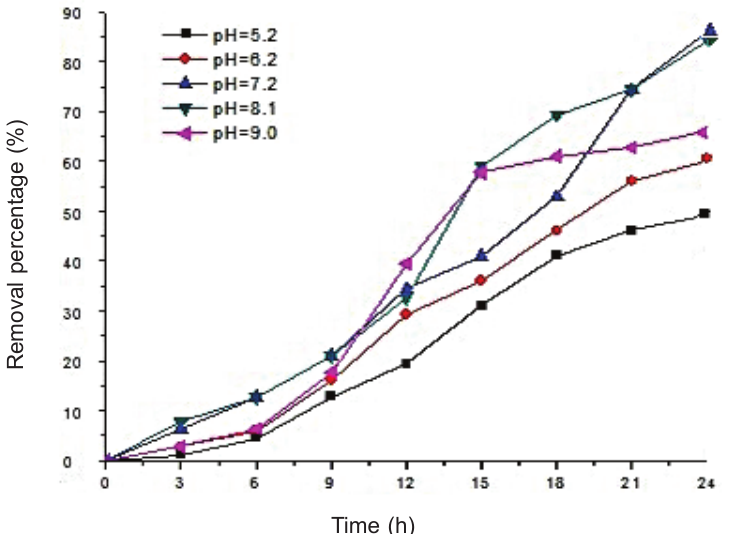
Fig. 4 – Effect of pH on the phenol degradation of strain